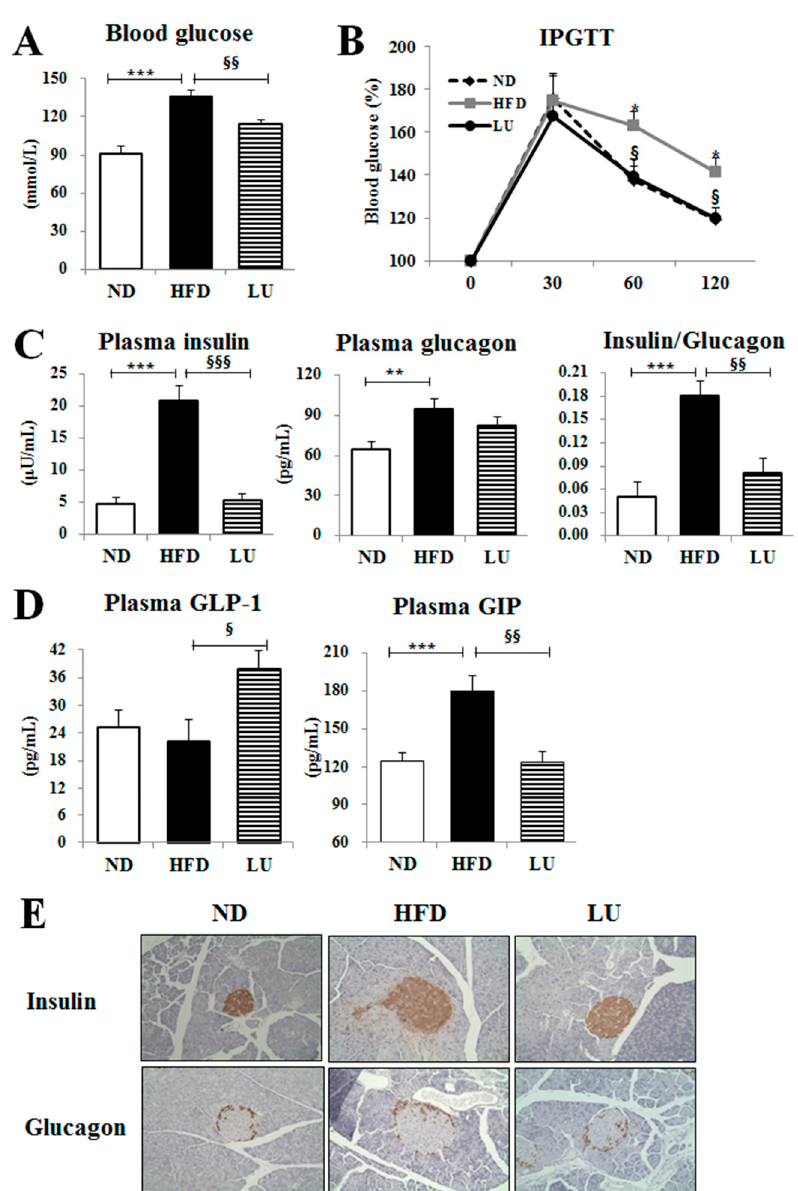
Figure 3. Effect of luteolin treatment for 16 weeks on insulin resistance (IR)-related markers, and immunohistochemistry staining of pancreatic insulin and glucagon in C57BL/6J mice fed the high-fat diet. ( A ) Blood glucose levels after 12 h of fasting. ( B ) IPGTT after 12 h of fasting. ( C ) Plasma levels of insulin and glucagon, and ratio of insulin and glucagon. ( D ) The plasma levels of incretin hormones GLP-1 and GIP. ( E ) Immunohistochemistry staining for insulin and glucagon of the pancreas (200× magnification). Data are shown as means ± SEM. ND vs HFD: * p < 0.05, ** p < 0.01, *** p < 0.001. HFD vs LU: § p < 0.05, §§ p < 0.01, §§§ p <